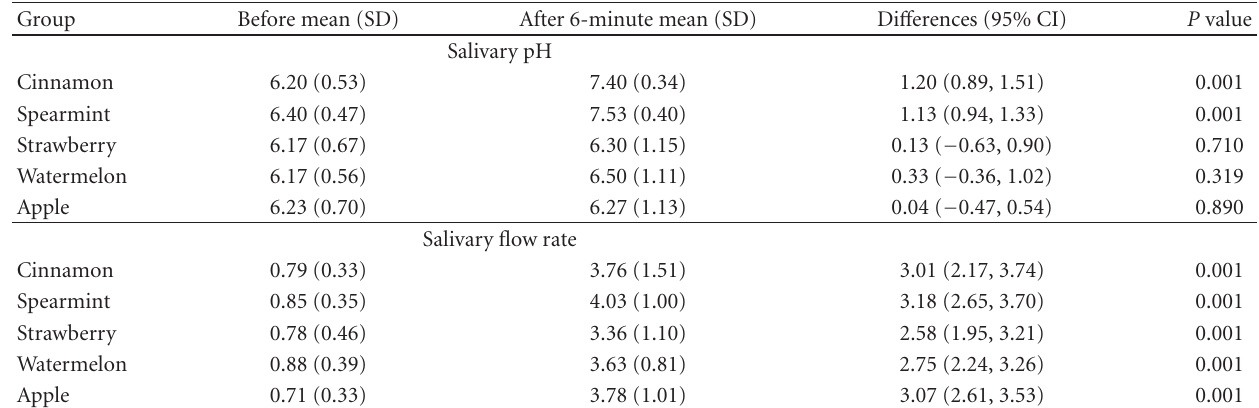
Table 2: Salivary flow rate and pH di ff erences before and 6 min after the start of di ff erent flavored chewing gums.